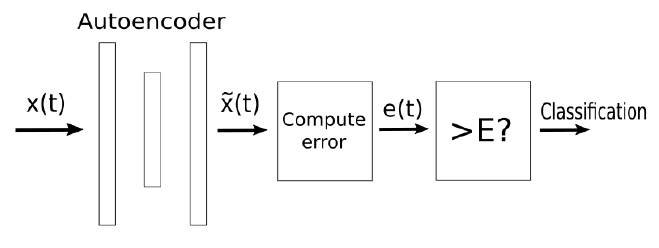
Figure 2. Classification scheme.